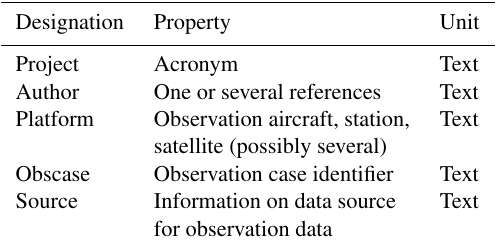
Table 5. Contrail observation